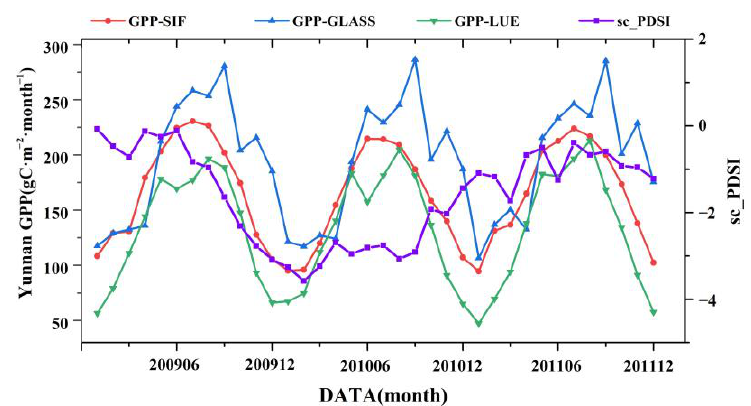
Figure 11. Changes in the three types of GPP and sc_PDSI in Yunnan Province, 2009 – 2011.